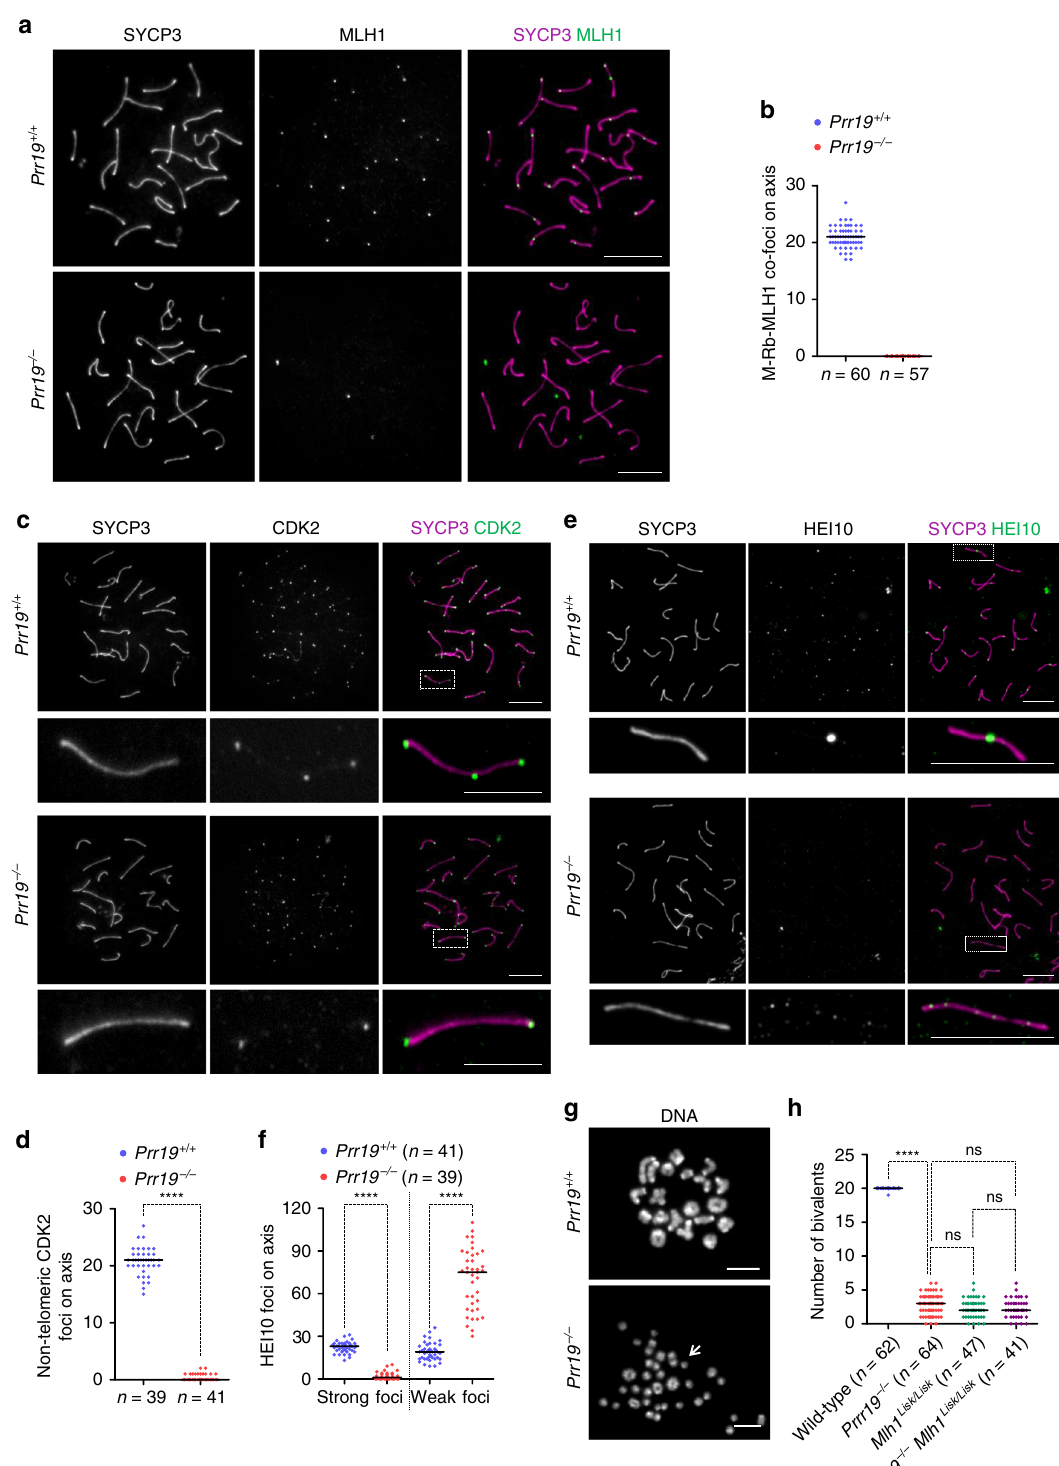
the diakinesis/metaphase I stages. Whereas 20 bivalents were observed in wild-type, the median bivalent number was only three in Prr19 − / − spermatocytes (Fig. 4g, h), indicating that most, but not all, crossovers require PRR19. Bivalent numbers were similar in Prr19 − / − , Mlh1 Lisk/Lisk (see ref. 3 for Mlh1 Lisk allele) and double-mutant Prr19 − / − Mlh1 Lisk/Lisk mice (Fig. 4h), indi- cating that PRR19 and MutL γ act in the same crossover